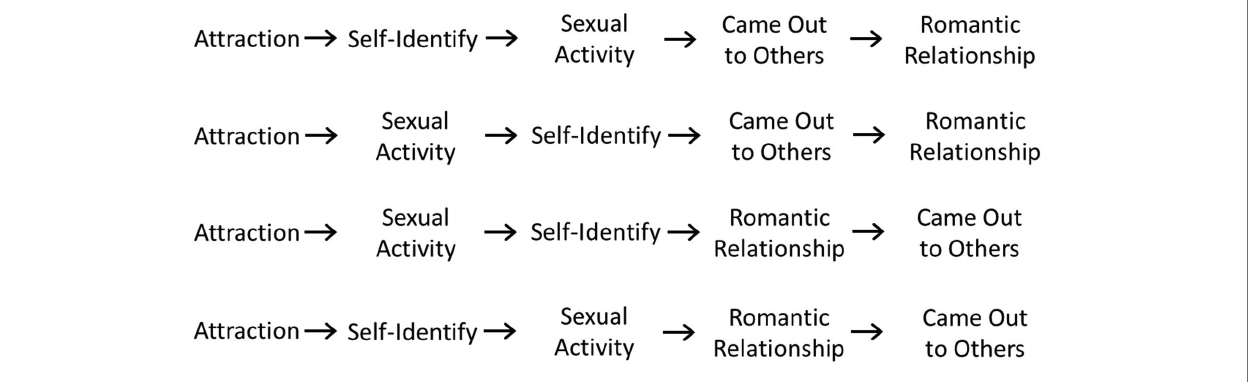
FIGURE 2 | Common Sequences of LGB+ Identity Development